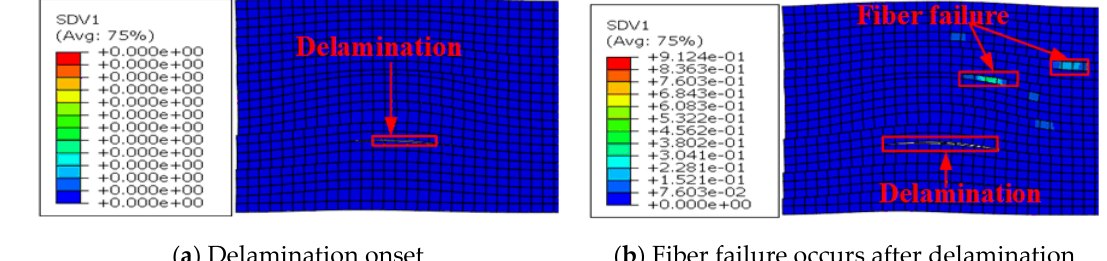
Figure 17. Elastoplastic model prediction of damage sequence for a laminate with wrinkle level 11.4°.